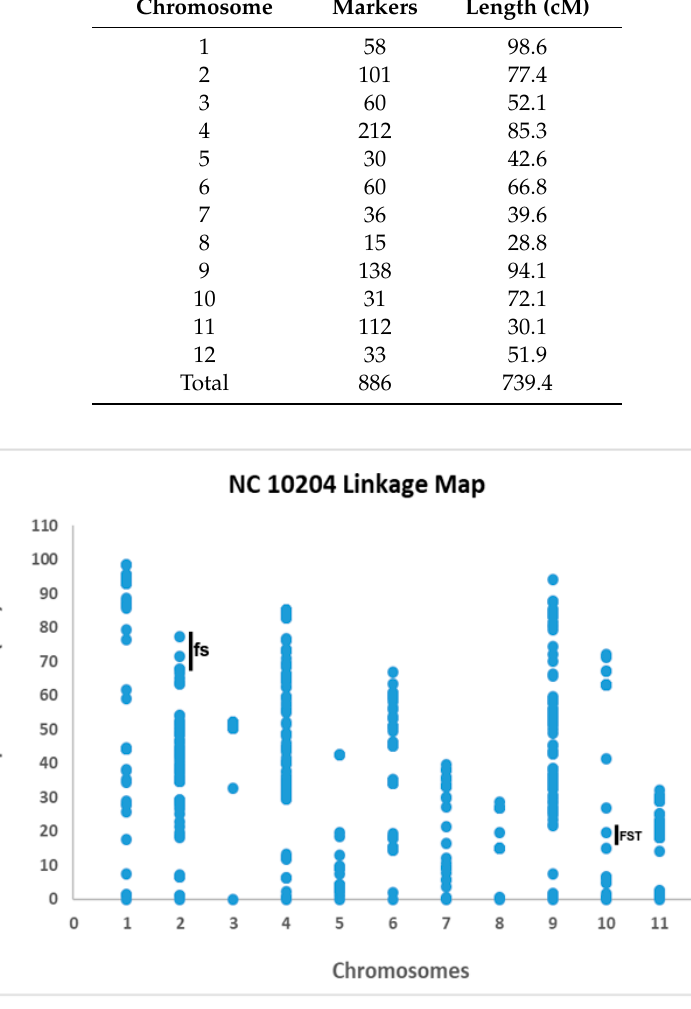
Figure 4. Linkage map of NC 10204. The x-axis represents chromosomes, and y-axis represents the genetic map position of the markers in each chromosome. The blue dots represent the markers in each chromosome. Black bars represent the QTL that were detected in two years in the same positions. The red star indicates the QTL that were detected in two years but in different genetic positions. ‘fs’ denotes fruit size traits that include area, perimeter, width mid-height, and maximum width, ‘FST’ denotes fruit shape triangle, and ‘Ob’ denotes obovoid. Table 5. Summary of the linkage map of NC 10204 showing 12 chromosomes along with the number of markers per chromosome and the length of each chromosome.